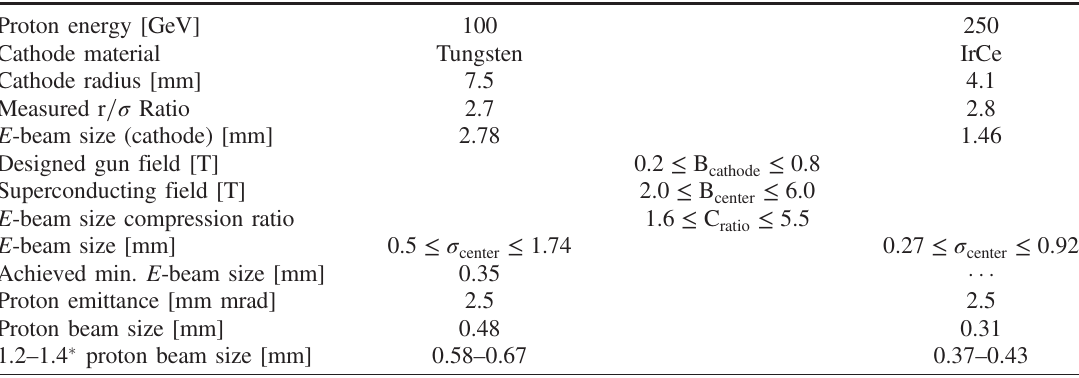
TABLE III. Parameters for the electron gun